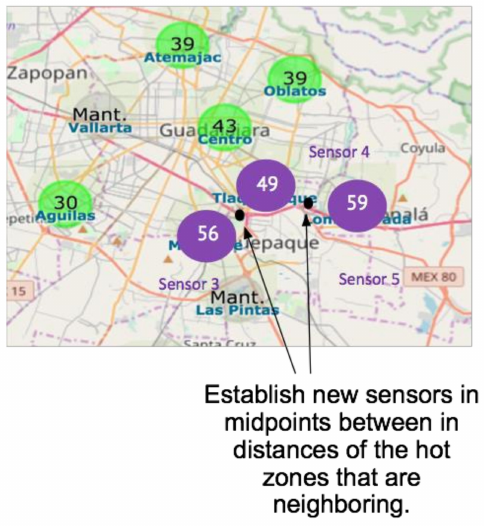
Figure 8. Georeferenced map the neighbor’s sensor border on a first run of a recursive